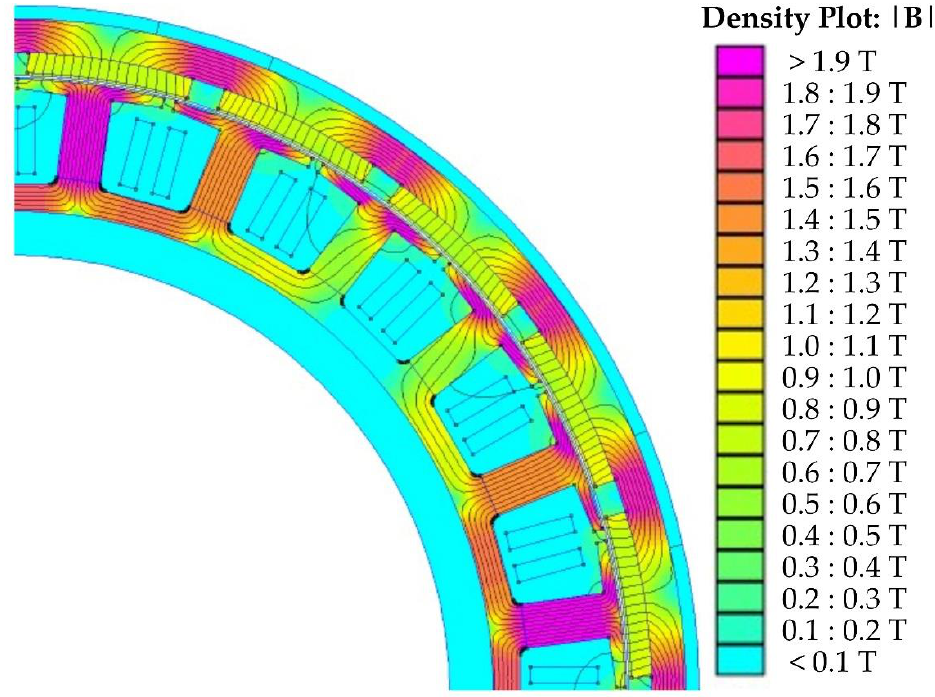
Figure 3. Distribution of the flux density from permanent magnets in the elements of the electromagnetic circuit of the motor model.